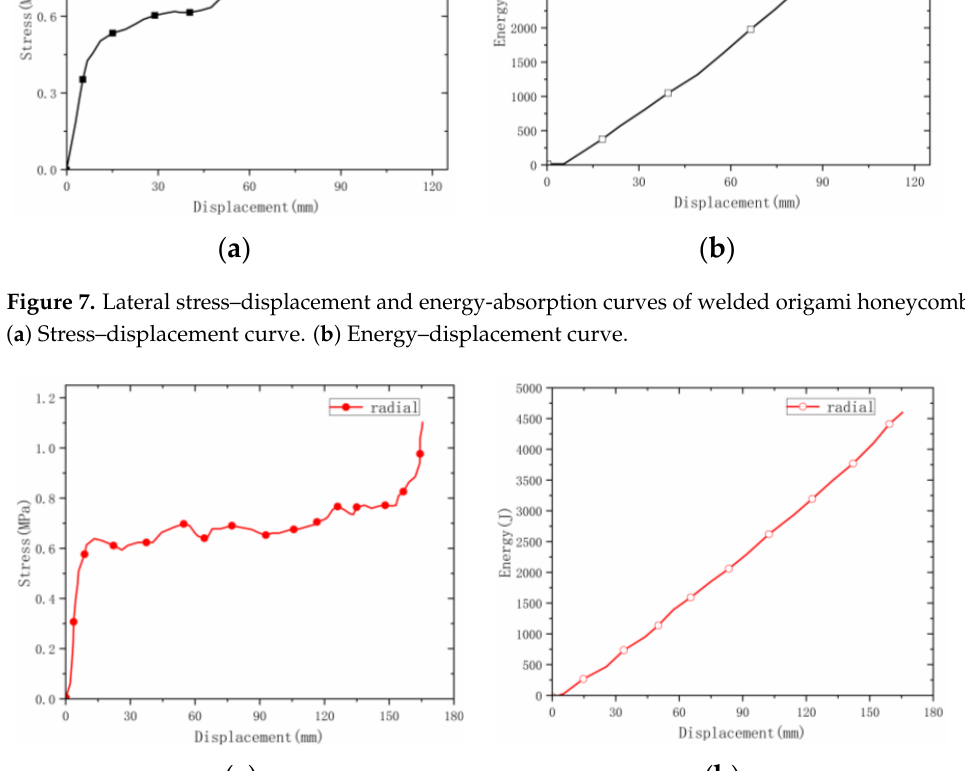
Figure 8. Radial stress–displacement and energy-absorption curves of welded origami honeycomb 2. ( a ) Stress–displacement curve. ( b ) Energy–displacement